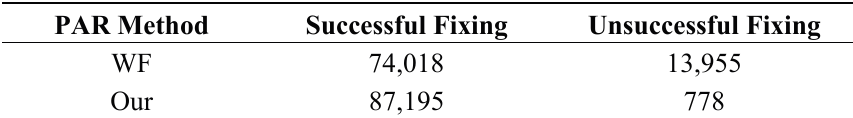
Table 1. The number of successful and unsuccessful fixing epochs obtained by WF and our PAR